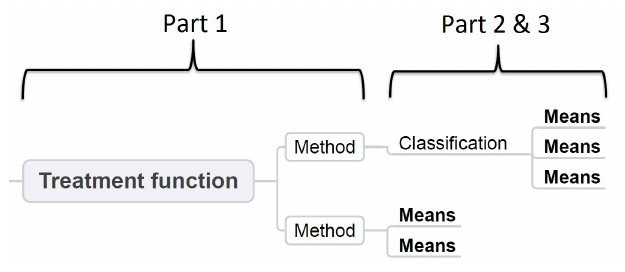
Figure 2. Scope of this